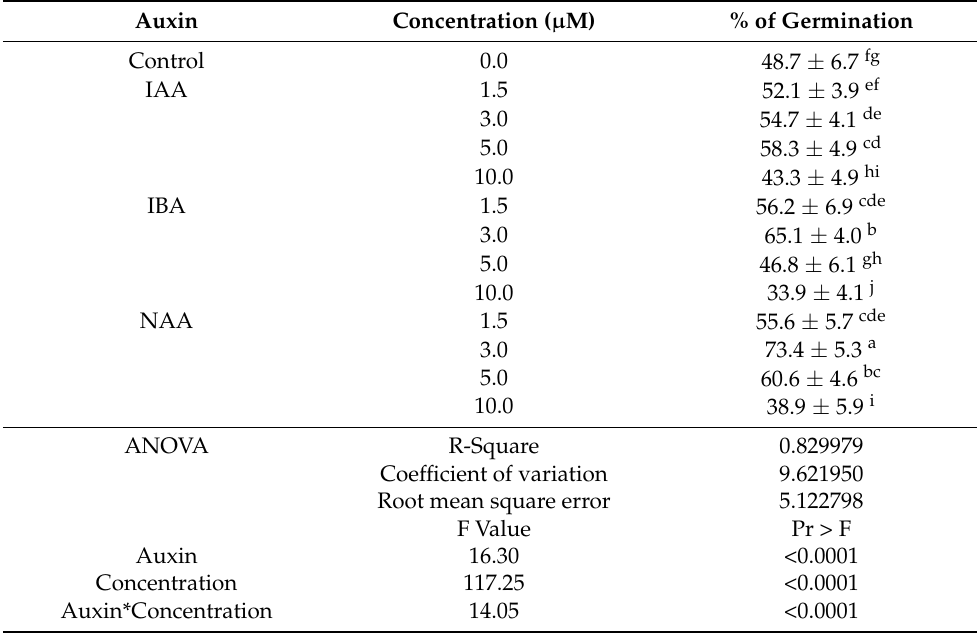
Table 3. Effect of auxins on seed